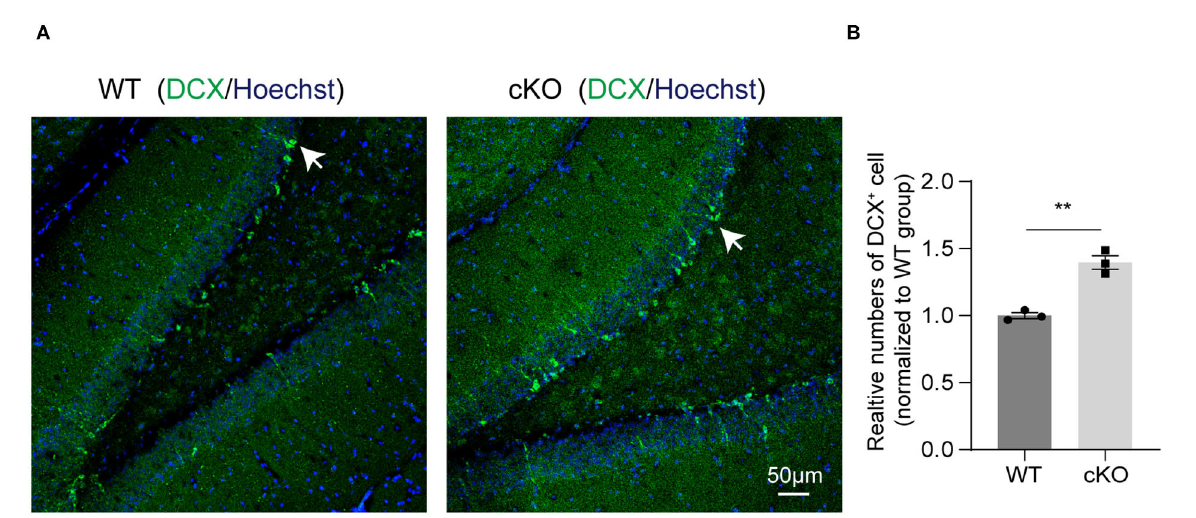
FIGURE6 MAD2B cKO promoted neurogenesis in the DG of the hippocampus. (A) Representative confocal fluorescent images of DCX in the DG of the WT and the cKO groups. White arrows point to DCX positive neurons. The scale bar is 50 µ m. (B) Quantification of DCX + cells in the DG of the two groups ( n = 3, p = 0.0019, t = 7.236, unpaired two-tailed t -test). ** P < 0.01. All data are displayed as means ± s.e.m.